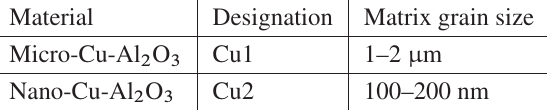
Table 1. Experimental